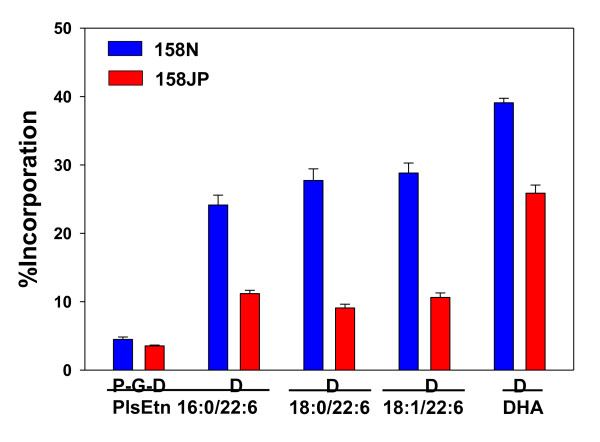
Incorporation of PPI-1038 (100 μM; 72 hr) into the 16:0/22:6, 18:0/22:6 and 18:1/22:6 plasmalogens of 158N and 158JP oligodendrocytes. N = 5. P = [13C16]palmitic acid; G = [13C3]glycerol; D = [13C3]DHA.